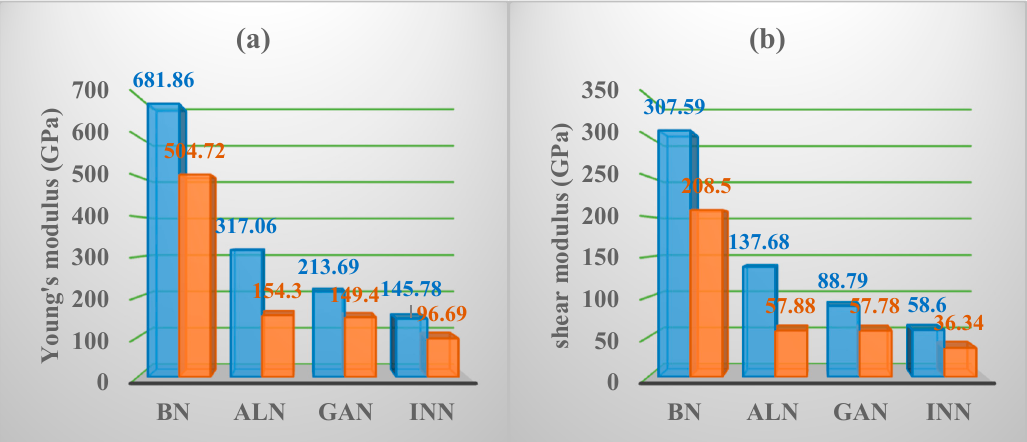
Figure 4. The three-dimensional contour plots of the Young’s modulus for BN ( a ), AlN ( b ), GaN ( c ), and InN ( d ) in the Pm − 3 n phase.